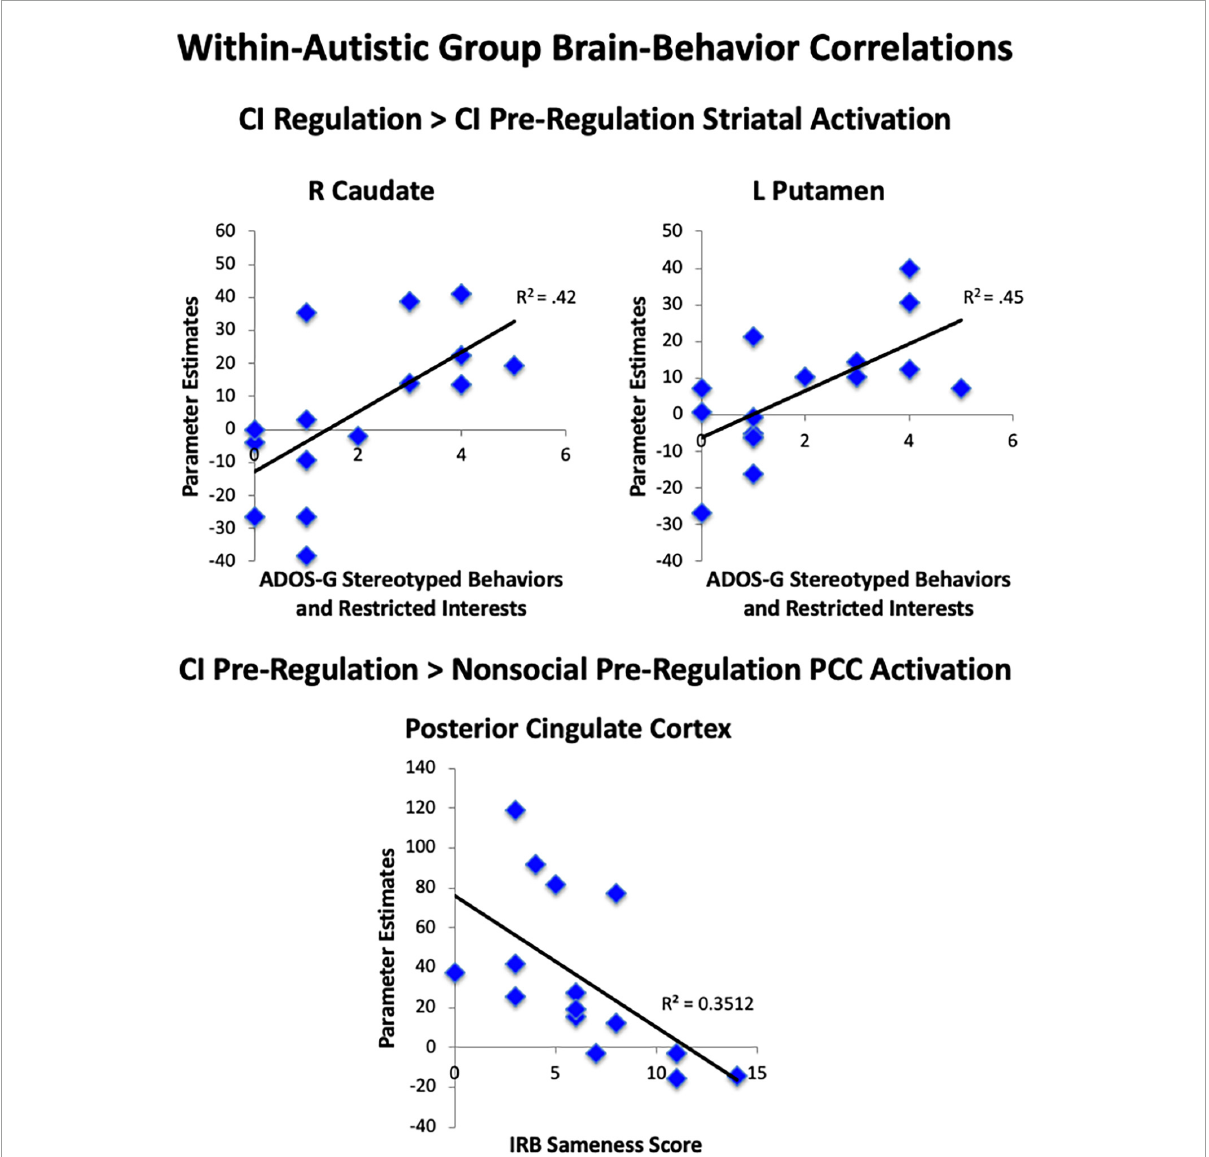
FIGURE7 Brain-behavior correlations. Within the autistic group, correlations were found between less striatal area activation during viewing of CI images and greater RRBI. Correlations were found for greater striatal area activation when regulating CI than when viewing CI and greater